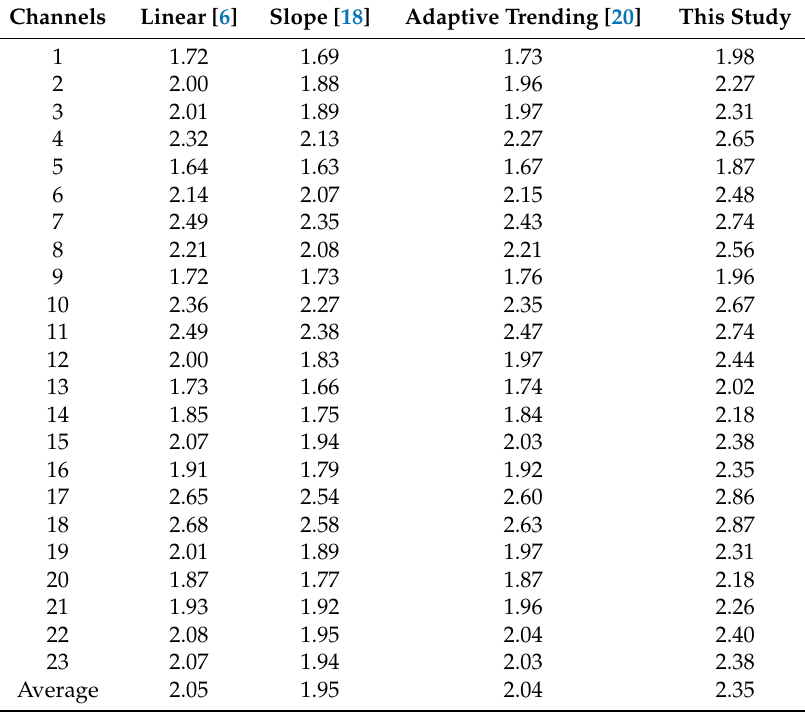
Table 2. Compression rates of different prediction methodologies for 23 channels of CHB-MIT Scalp EEG